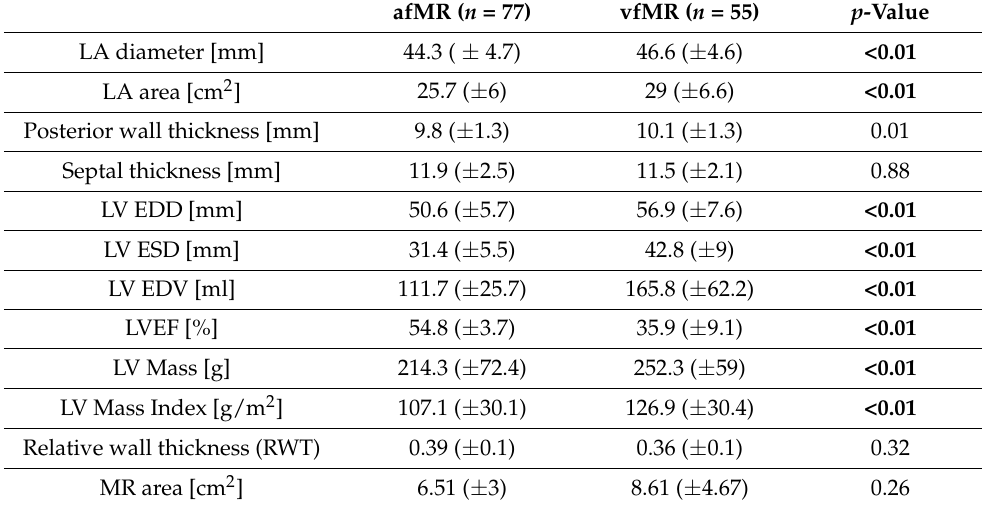
Table 3. Comparison of echocardiographic parameters between patients with afMR and